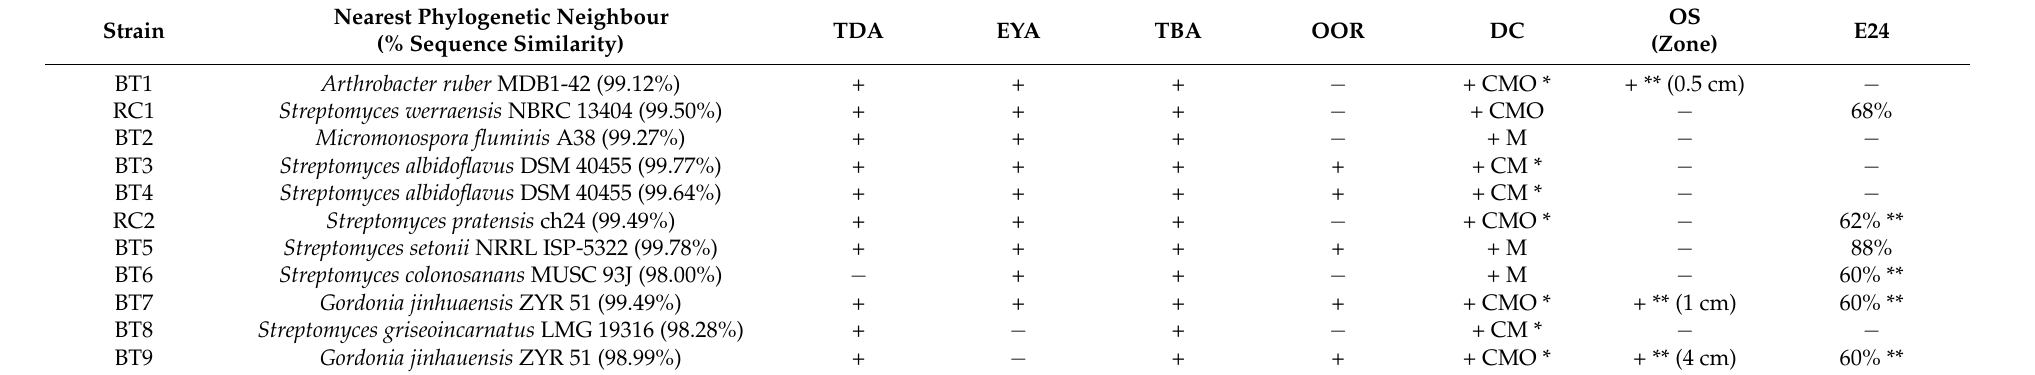
Gordonia jinhauensis ZYR 51